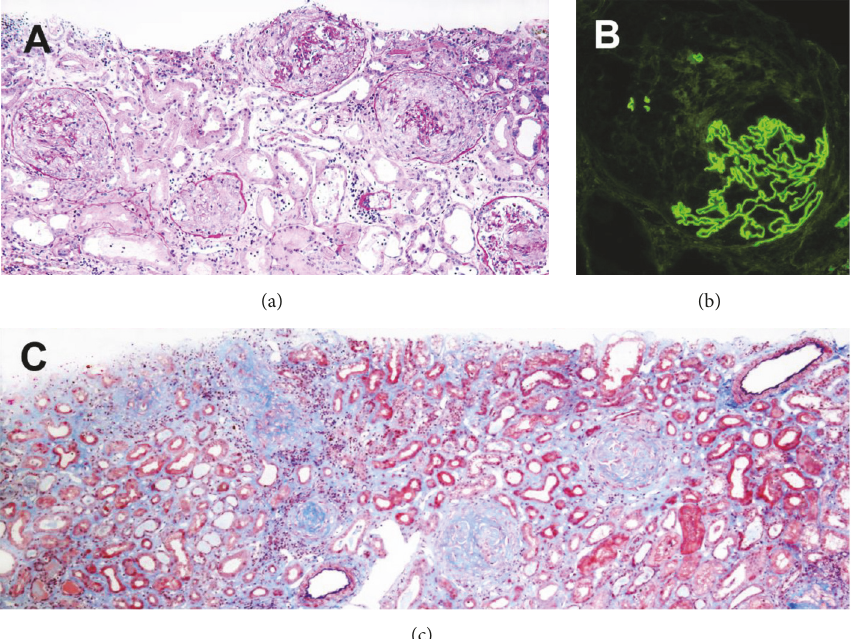
Figure2:Lightmicroscopicfindingsof1st(aandb)and2nd(c)kidneybiopsies.(a)Thereareglomerulidemonstratingcellularorfibrocellular crescents with or without focal segmental necrosis and diffuse inflammatory cell infiltration, patchy tubular injury, and mild fibrosis in the tubulointerstitial areas (PAS staining, × 200). (b) Immunofluorescent staining for IgG shows linear staining along with glomerular capillary walls, × 400. (c) There are globally sclerotic glomeruli and diffuse tubulointerstitial fibrosis with mononuclear cell infiltration and tubular atrophy (Elastica-Masson staining, ×